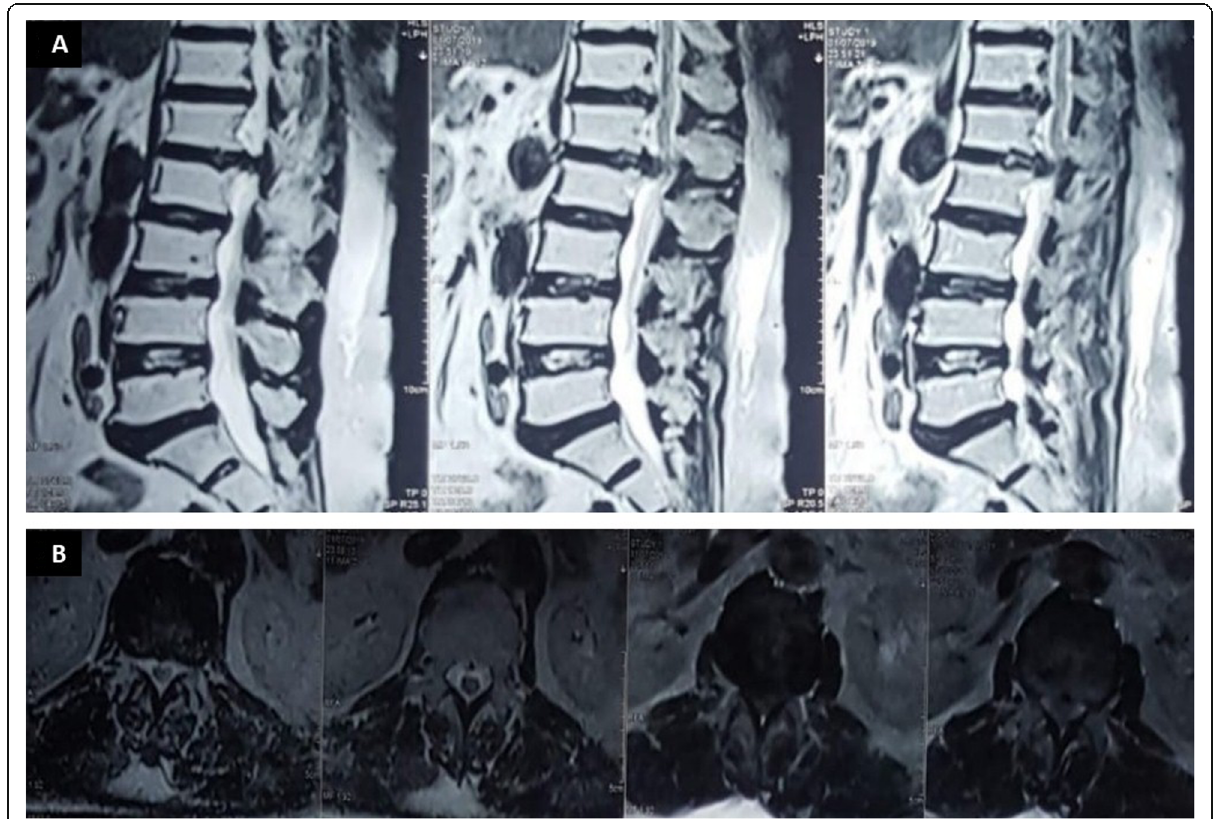
Fig. 1 Preoperative MRI of the lumbosacral spine. a Preoperative T2-weighted Sagittal image of a 42-year-old male presented with bilateral femoralgia and motor deficit for 3 months. b MR of axial image showed L1-L2 sizable herniated disc compromising the conus